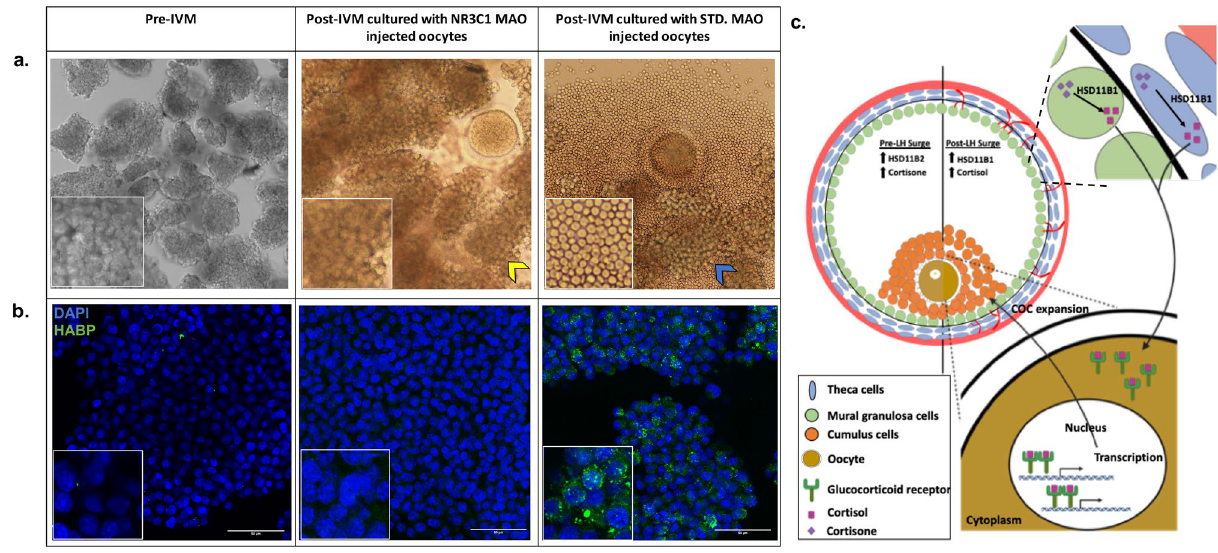
Figure 6. NR3C1 is essential for cross-communication between the oocyte and the surrounding CCs. ( a ) Stereomicroscope image of CC morphology immediately after aspiration and prior to IVM (left) and in the presence of a NR3C1 MAO-injected oocyte (middle) versus an STD MAO-injected oocyte (right) after IVM. Note the clumped CCs (image insets) in the pre-IVM and NR3C1 MAO co-cultures (yellow arrowhead) compared to the single CCs visible following expansion (blue arrowhead) ( b ) IF detection of HA using HABP confirmed a lack of expansion in pre-IVM CCs and those incubated with NR3C1 MAO-injected oocytes as evidenced by the little to no HABP (green) immunostaining in CCs also stained with DAPI (blue). In contrast, robust HABP immunostaining was observed in the CCs co-cultured with STD MAO-injected oocytes. ( c ) A proposed model for NR3C1-dependent bidirectional communication between the oocyte and somatic cells. The increased relative level of HSD11B1 to HSD11B2 in the mGCs/CCs (green) and the theca cells (blue) convert cortisone to cortisol post-LH surge, with cortisol binding to NR3C1 in the oocyte. Nuclear translocation of cortisol bound NR3C1, activation of transcription, and further unknown downstream events leads to COC expansion that takes place during meiotic maturation of the